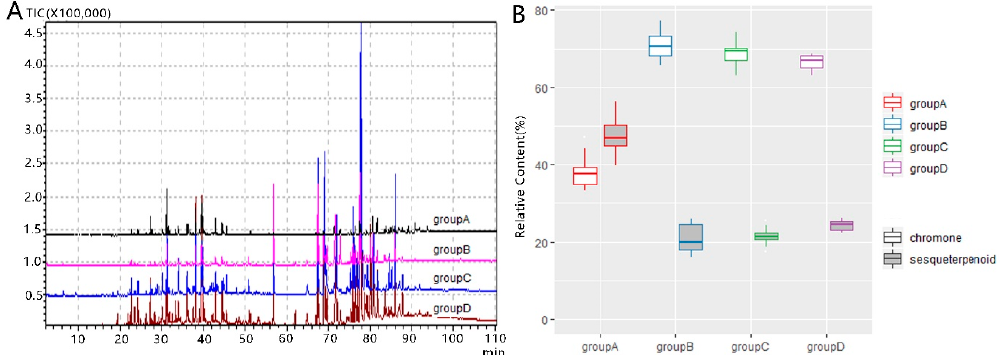
Figure 2. GC-MS analysis of artificial agarwood induce by different techniques. A . Representative chromatographs of artificial agarwood. B . Relative contents of main components detected by GC-MS. group A, wounding by axe; group B, burning-chisel-drilling; group C, chemical inducers; group D, biological inocula. Table 1. Tentative identification of chemical constituents in artificial agarwood.